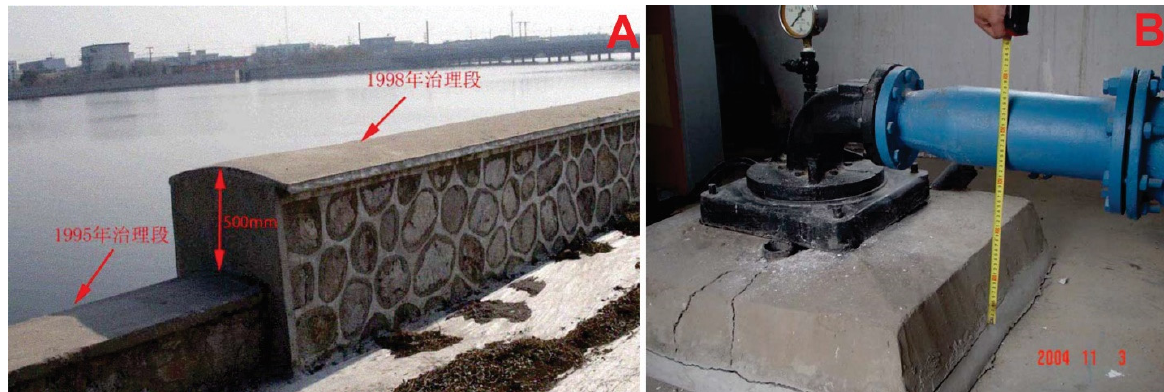
Figure 8. Land subsidence in the area of Tianjin city. ( A ) An increase in the height of the embarkments due to land subsidence 1995 and 1998 1998 Governance Section. ( B ) Damage to the water supply system [156] .